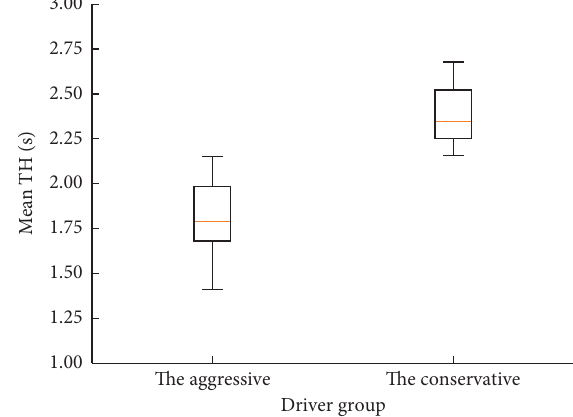
Figure 4: The boxplot of mean TH for the two groups of